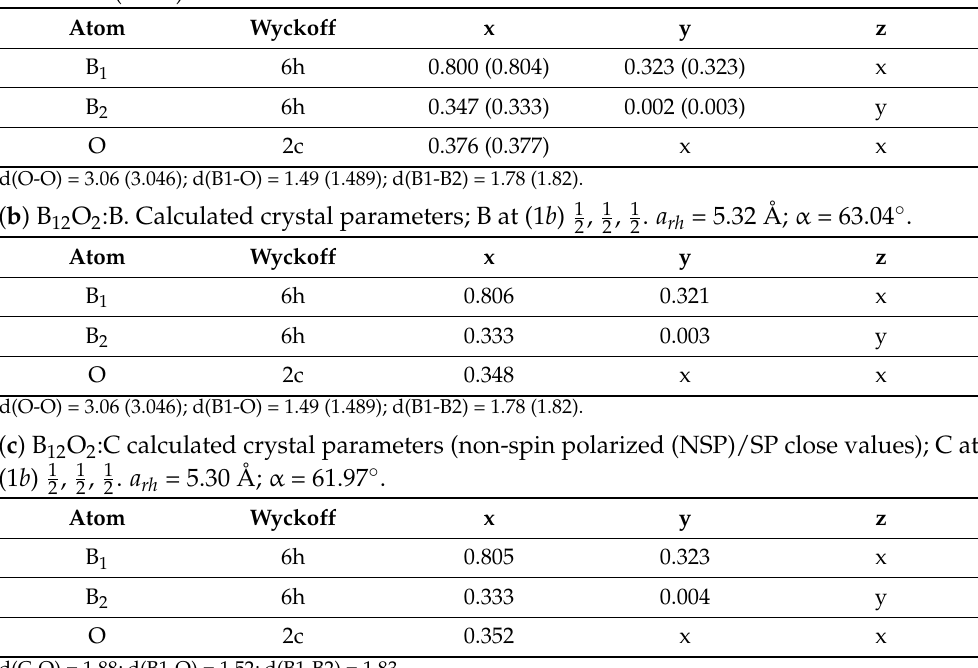
Table 1. Crystal data of B 12 O 2 :X family. Space group R 3 m , N ◦ 166. Rhombohedral settings. Void for interstitial atoms X: (1 b ) 1 (1Å = 10 − 10